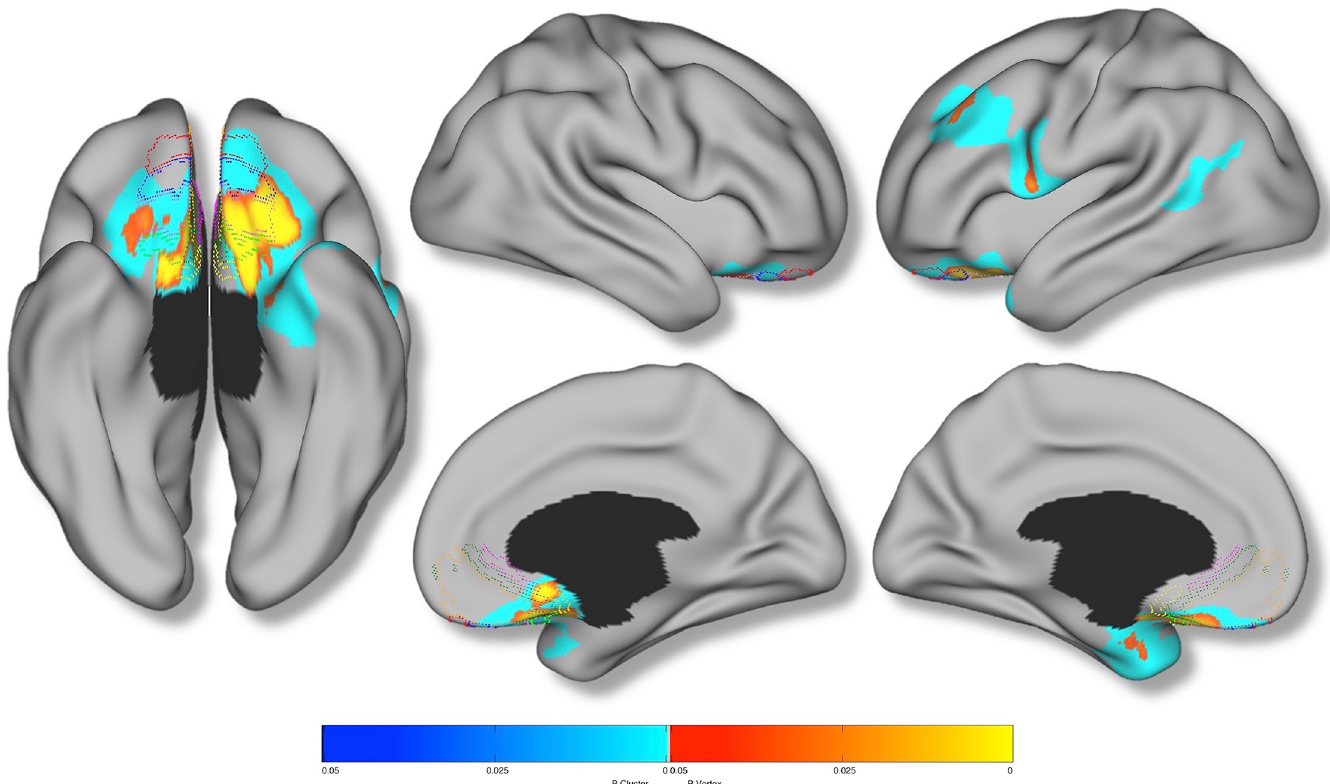
Fig 3. Results of “high reactive” group analysis. Brain areas in which local cerebral cortical thickness was significantly reduced in the “high reactive” group (n = 90) relative to all other participants (n = 1663). Random field theory was used to correct for multiple comparisons over the entire cortical mantle. Figure is shown at p � 0.05, RFT corrected. Blue areas are significant at the cluster level and red color corresponds to areas significant at the vertex level. Controlled for age, total brain volume, sex, site, handedness, Performance IQ, Verbal IQ, SES and pubertal development. Colored borders correspond to the maximum symmetric probability map derived from the cytoarchtectonic studies of Mackey & Petrides (2014).